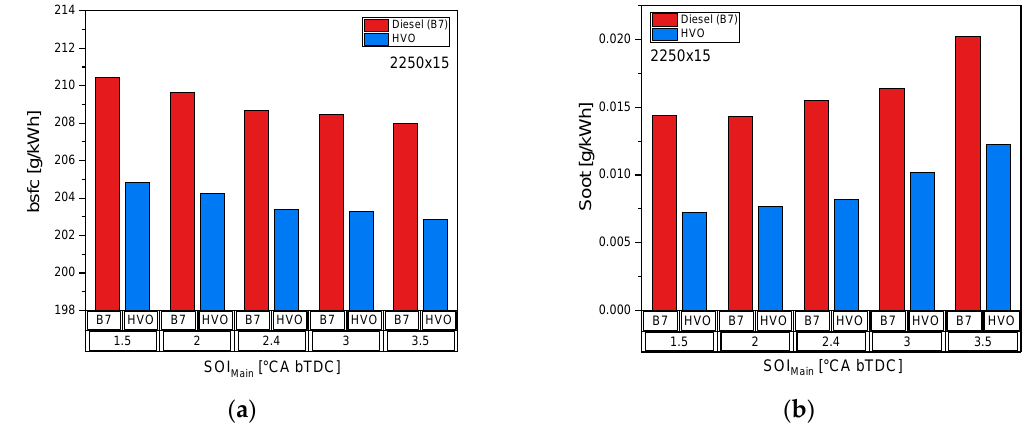
Figure 4. Influence of SOI Main on bsfc ( a ) and soot ( b ) for diesel and HVO at 2250 × 15.